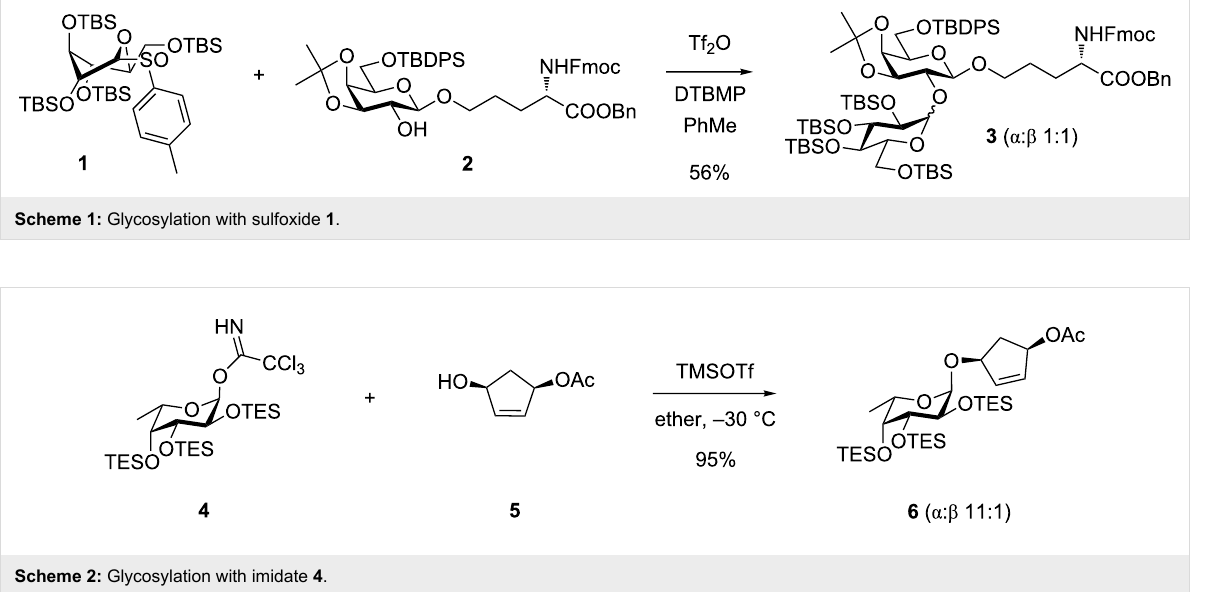
glucoside with TBS groups, oxidized the sulfur to sulfoxide 1 and used the latter to glucosylate the 2-OH of the galactose de- rivative 2 (Scheme 1). The reaction gave a 56% yield of 3 as a 1:1 mixture of α - and β -glucosides. Migration of a TBS group to the acceptor alcohol 2 was observed as a byproduct (10%). Attempts of glycosylating 2 with the thioglycoside or the corre- sponding glycosyl halides were unsuccessful. NMR studies of